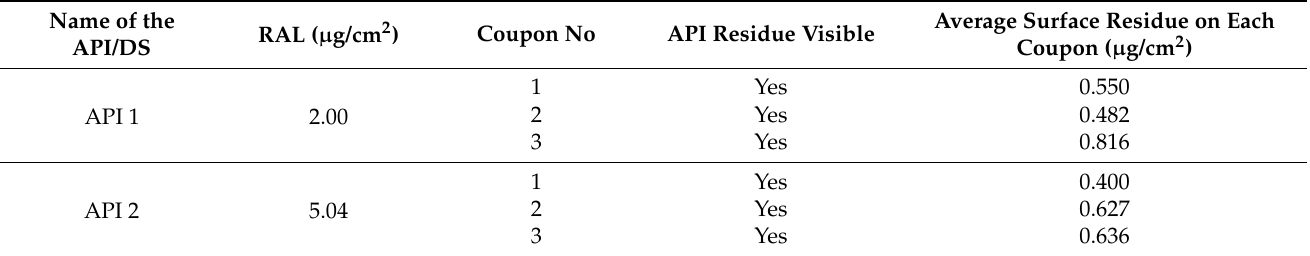
Table 3. A sample size of 10 was used to estimate the amount of API on the